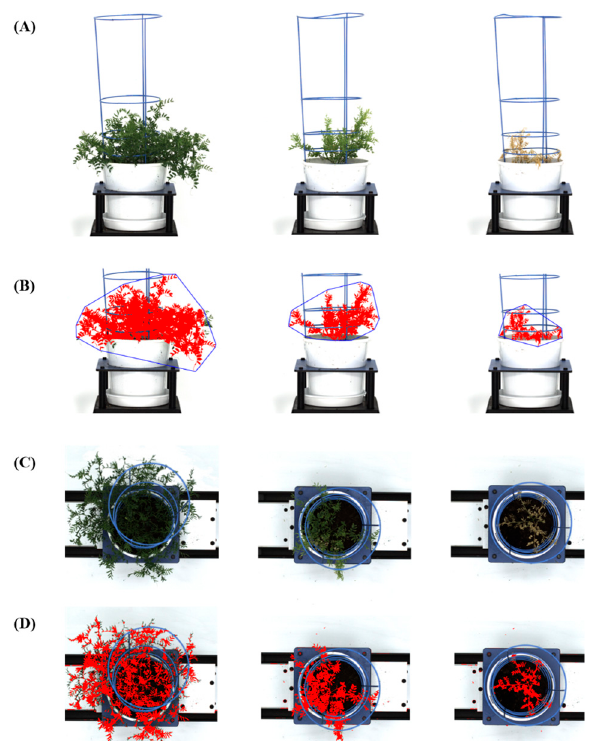
Figure 8. Snapshot red–green–blue (RGB) images of lentil accessions captured on the LemnaTec Scanalyzer 3D phenomics platform at two weeks after salt application. The images illustrate morphological variations in tolerant to intolerant lentil accessions (left to right): ( A ) side view, ( B ) side view where region-of-interest highlighted red with convex hull area marked in blue, ( C ) top-view, and ( D ) top-view where region-of-interest is highlighted in